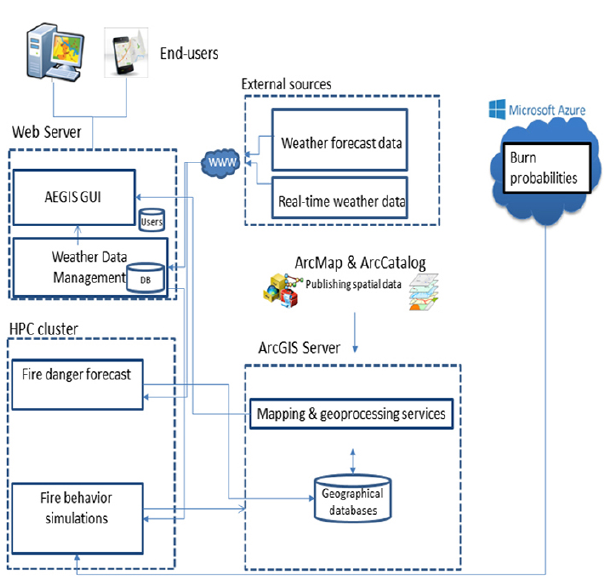
Figure 3. Architectural components of the AEGIS platform show- ing the linkages among data and computing